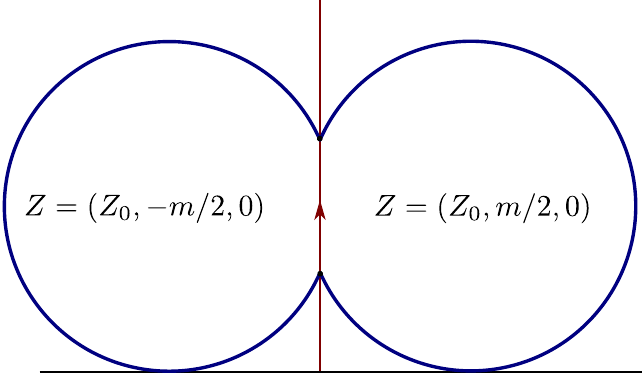
Figure 9 . The two-point function stays (cid:12)nite as the NAdS boundary touches the boundary of the true AdS, making the boundary length